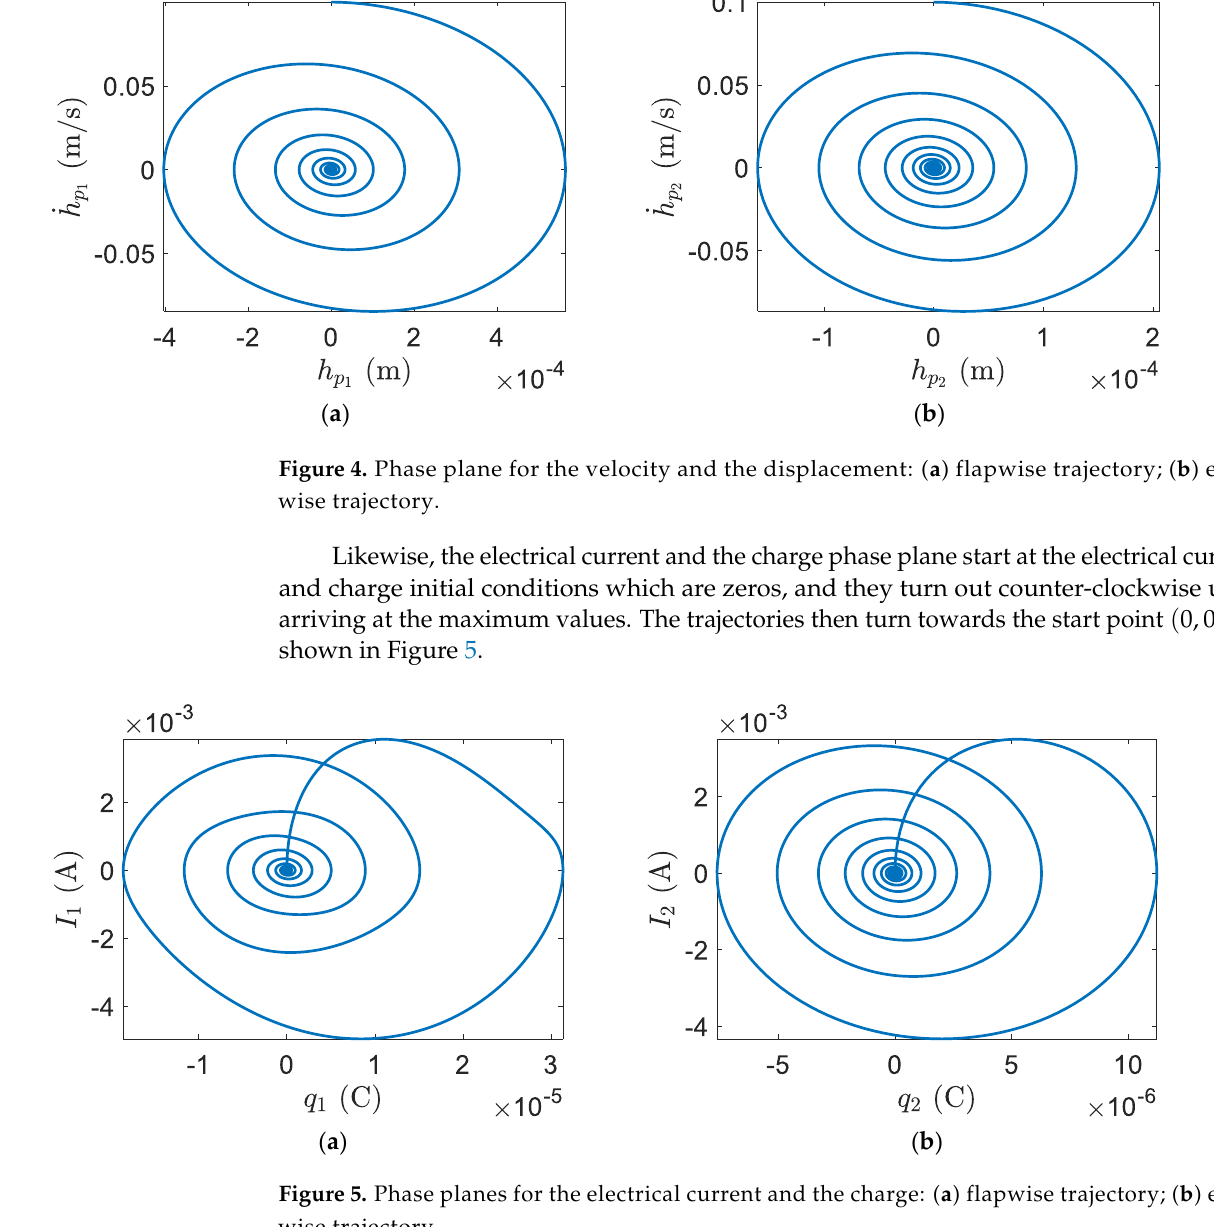
Figure 3. The smart blade system responses of the displacement: ( a ) flapwise oscillation; ( b ) edge- wise oscillation.